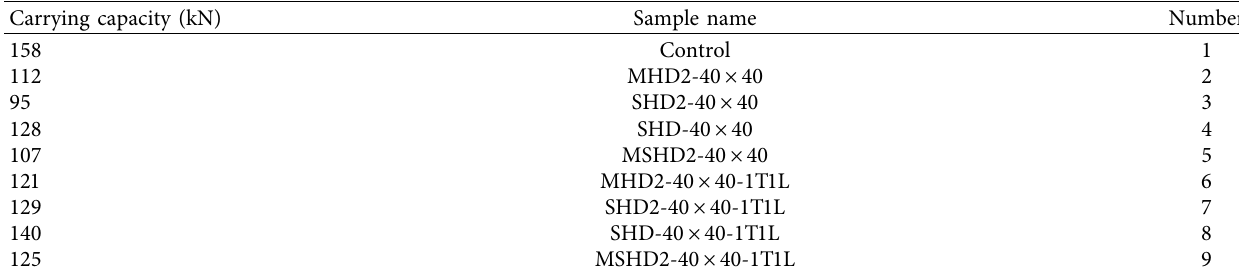
Table 7: Bearing capacity of laboratory